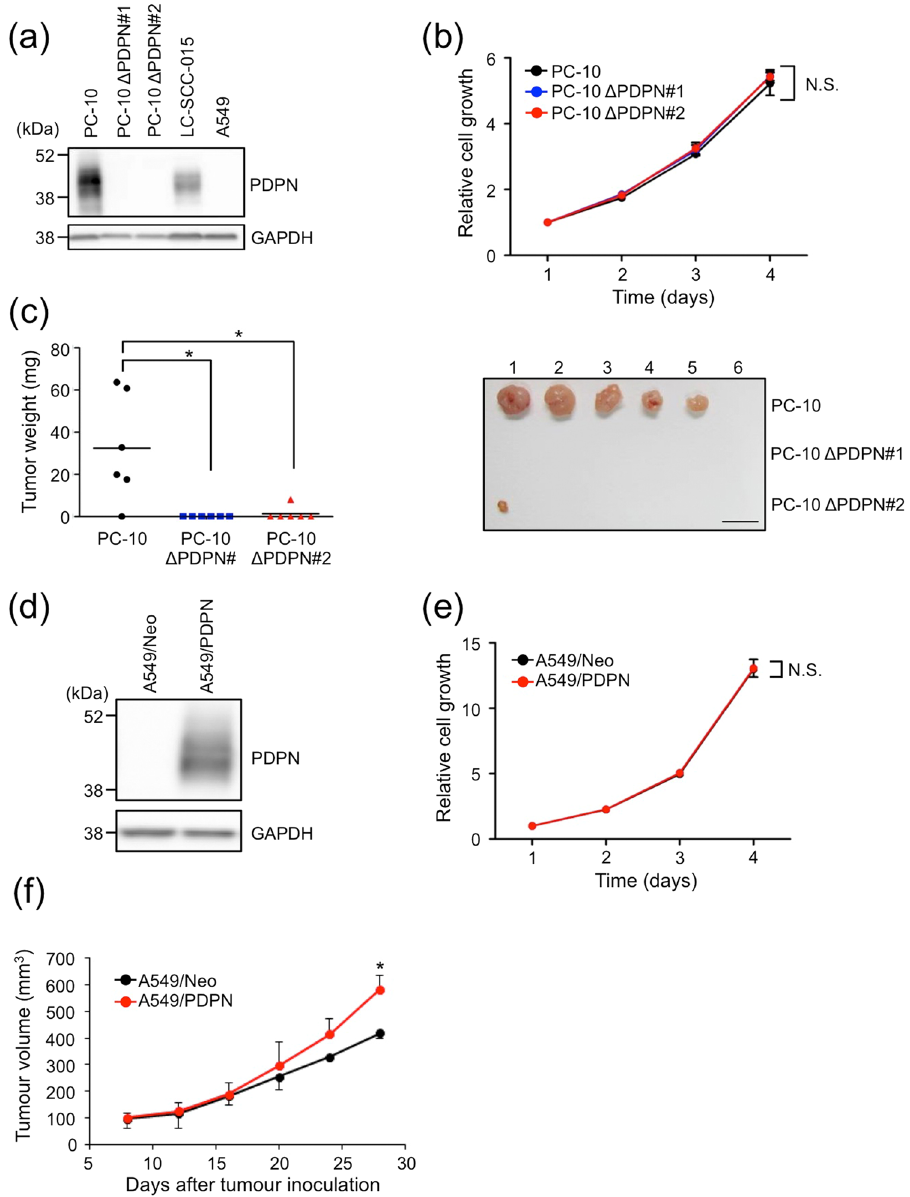
Figure 1. Podoplanin expression contributes to in vivo tumour growth but not in vitro cell growth. ( a ) Western blot analysis of podoplanin expression. The cell lysates of PC-10, podoplanin-knockout PC-10 (PC-10 Δ PDPN#1 and PC-10 Δ PDPN#2), SCC-015 and A549 cells were electrophoresed and immunoblotted with antibodies to podoplanin (PDPN) or GAPDH. Multiple exposure images of full-length blots were presented in Supplementary Fig. S8. ( b ) Role of podoplanin expression in cell growth in PC-10 cells in vitro . The in vitro cell growth in PC-10 and podoplanin-knockout PC-10 (PC-10 Δ PDPN#1 and PC-10 Δ PDPN#2) cells was estimated using CellTiter-Glo luminescent cell viability assay reagent. Relative cell growth was normalized to the luminescence on day 1. All data are shown as means ± SD of triplicate experiments. N.S.; Not significant by Mann–Whitney U -test. ( c ) PC-10 and podoplanin-knockout PC-10 (PC-10 Δ PDPN#1 and PC-10 Δ PDPN#2) cells (1 × 10 7 cells) were subcutaneously injected into nude mice (N = 6). After 23 days, the tumours were extracted and tumour weights were measured (Left). * P < 0.05 by the Mann–Whitney U -test. The extracted tumours are shown (Right, scale bar: 10 mm) ( d ) Cell lysates from A549 cells that had been transfected with pcDNA3-mock (A549/Neo) or pcDNA3-podoplanin (A549/PDPN) plasmid were immunoblotted with antibodies to podoplanin (PDPN) or GAPDH. Multiple exposure images of full-length blots were presented in Supplementary Fig. S8. ( e ) In vitro cell growth in A549/Neo and A549/PDPN cells was estimated using CellTiter-Glo luminescent cell viability assay reagent. Relative cell growth was normalized to the luminescence on day 1. All data are shown as means ± SD of triplicate experiments. N.S.; Not significant by Student’s t -test. ( f ) A549/Neo and A549/PDPN cells (5 × 10 6 cells) were subcutaneously injected into nude mice (N = 3). The tumour volume was measured every 4 days. * P < 0.05 by Mann–Whitney U